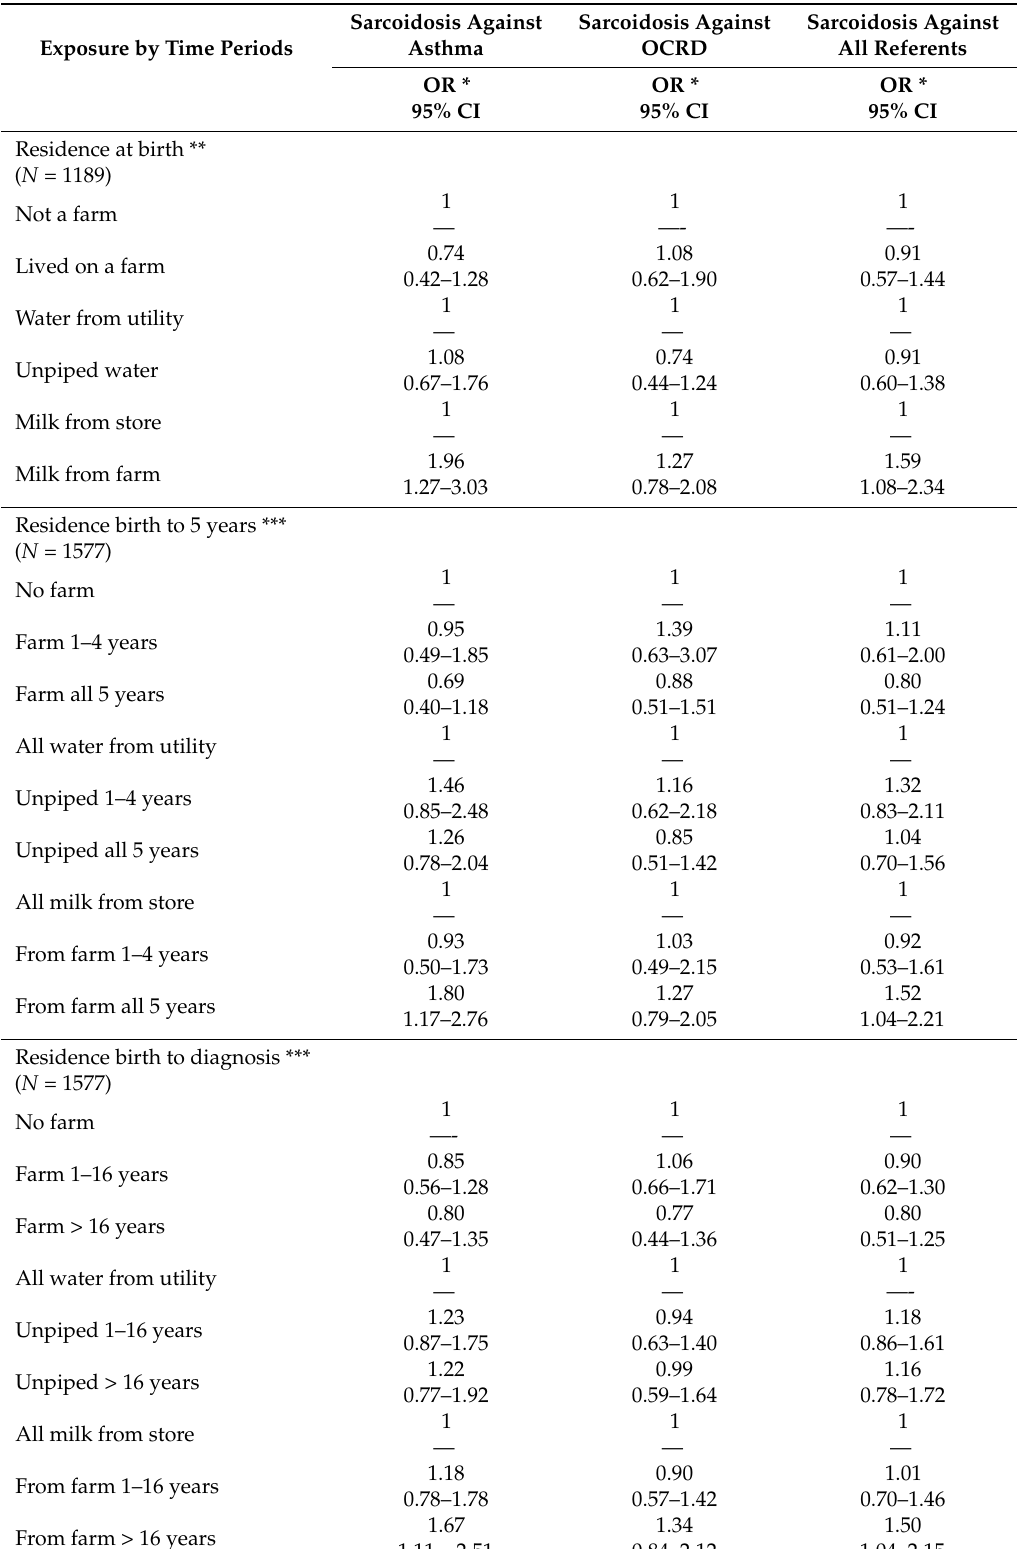
Table 3. Multivariable logistic regression models comparing cases of sarcoidosis against referent groups including all exposures within each of 3 time